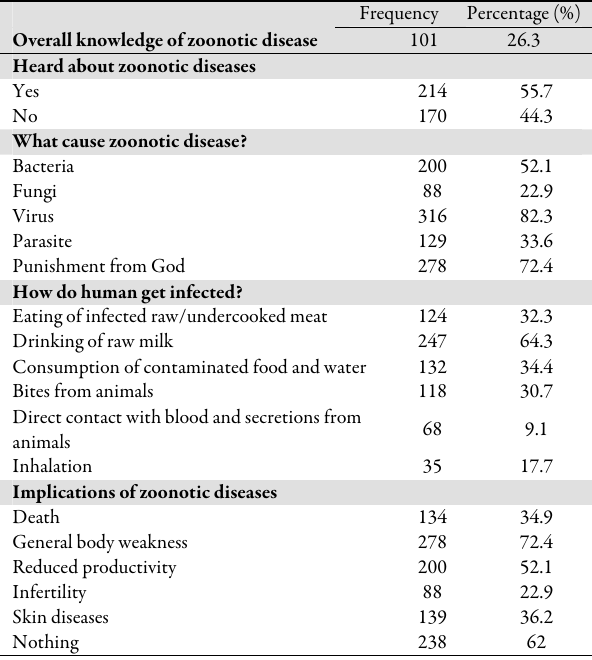
Table 2. Perceptions/level of knowledge possessed by respondents about zoonotic